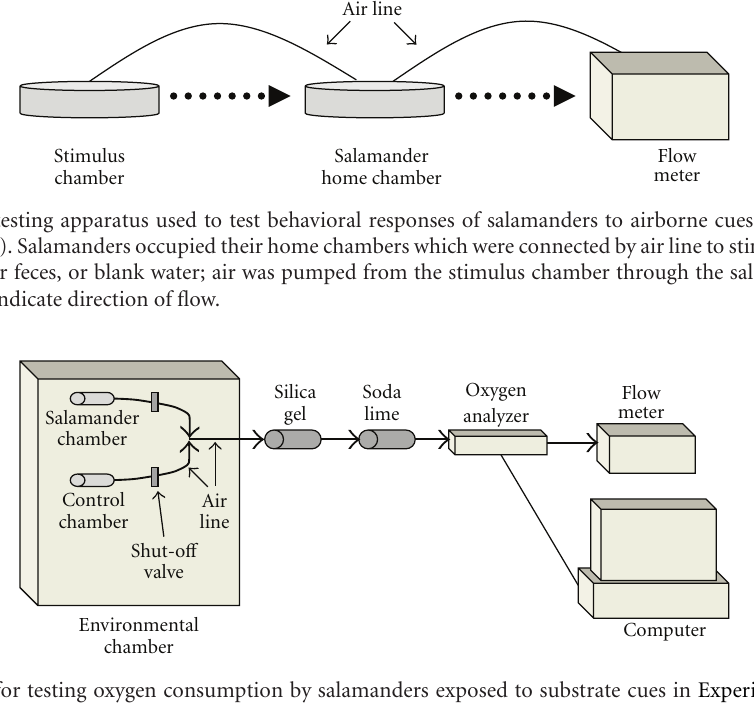
Figure 2: Apparatus used for testing oxygen consumption by salamanders exposed to substrate cues in Experiment 3 (diagram modified from Windel 2005). Air from a cylindrical chamber holding a salamander was pumped by the flow meter through an oxygen analyzer to measure oxygen consumption during a sealed-chamber period of 12min. Dark arrows indicate direction of